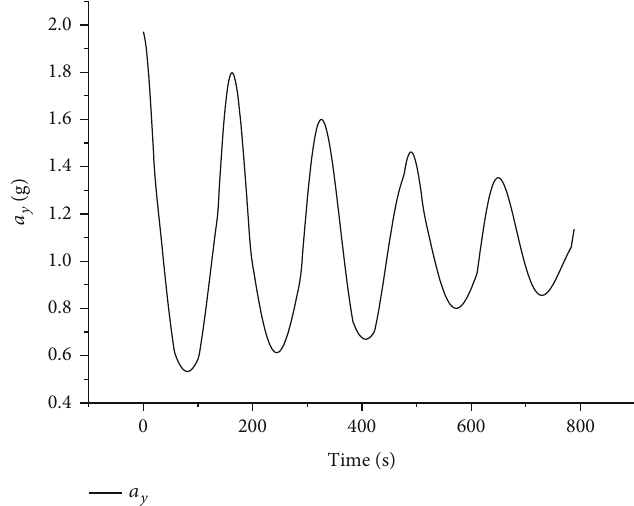
Figure 6: Normal acceleration with constant optimal angle of attack.